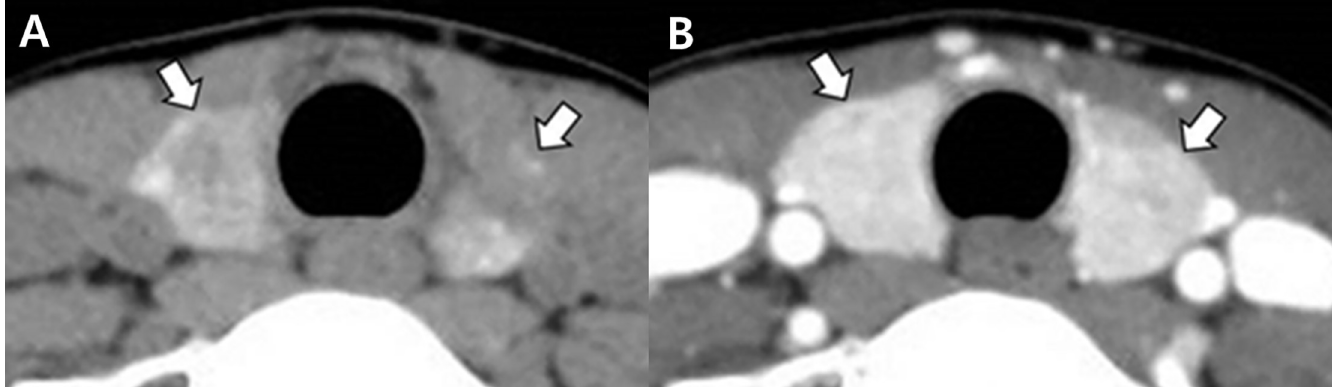
Fig 2. Computed tomography (CT) images in a 24-year-old woman with Hashimoto thyroiditis that was designated as “diffuse thyroid disease” CT category (papillary thyroid carcinoma in the right lobe). The thyroid gland (arrows) shows decreased and inhomogeneous attenuation in the non-enhanced CT image (A), and decreased and inhomogeneous enhancement in the contrast-enhanced CT image (B), but an anteroposterior diameter of 1–2 cm and a smooth margin in both the non- enhanced and contrast-enhanced CT